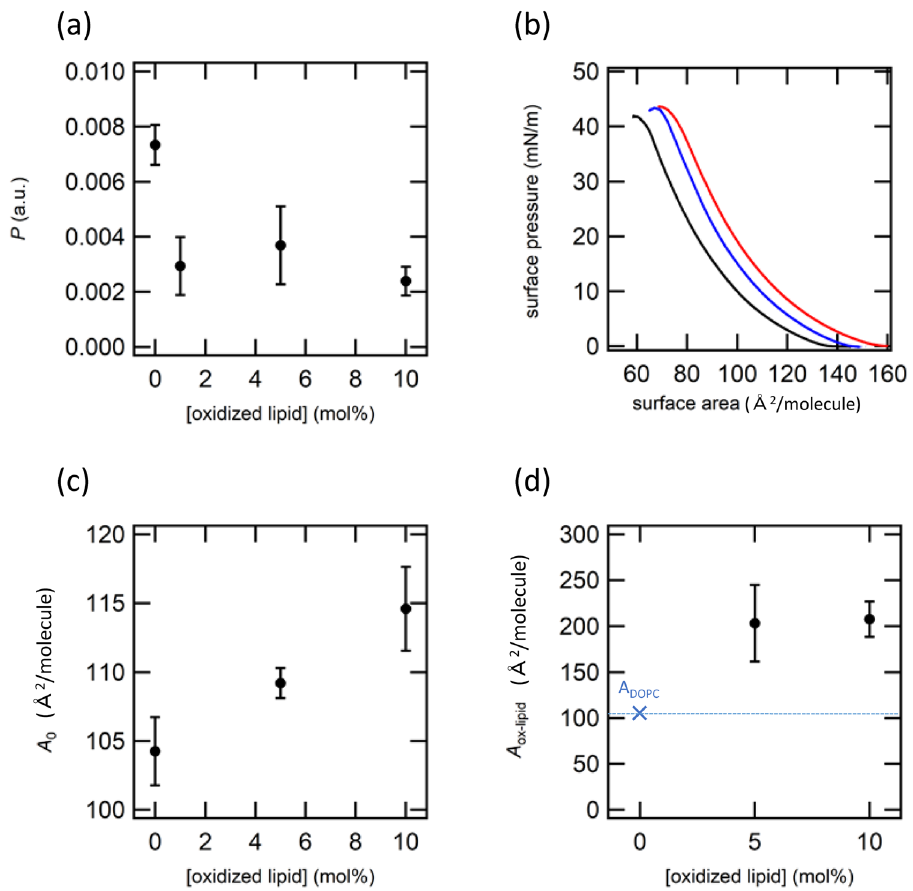
Figure 4. Data for PoxnoPC. The permeation rate P as the function of the concentration of PoxnoPC. ( b ) π – A curves of DOPC/PoxnoPC monolayers. The concentrations of PoxnoPC are 0 (black), 5 (blue), and 10 (red) mol %. ( c ) Averaged limiting area ( A 0 ) estimated from π – A curves as the function of the concentration of PoxnoPC. ( d ) Calculated limiting area of oxidized lipid ( A ox-lipid ) as the function of the concentration of